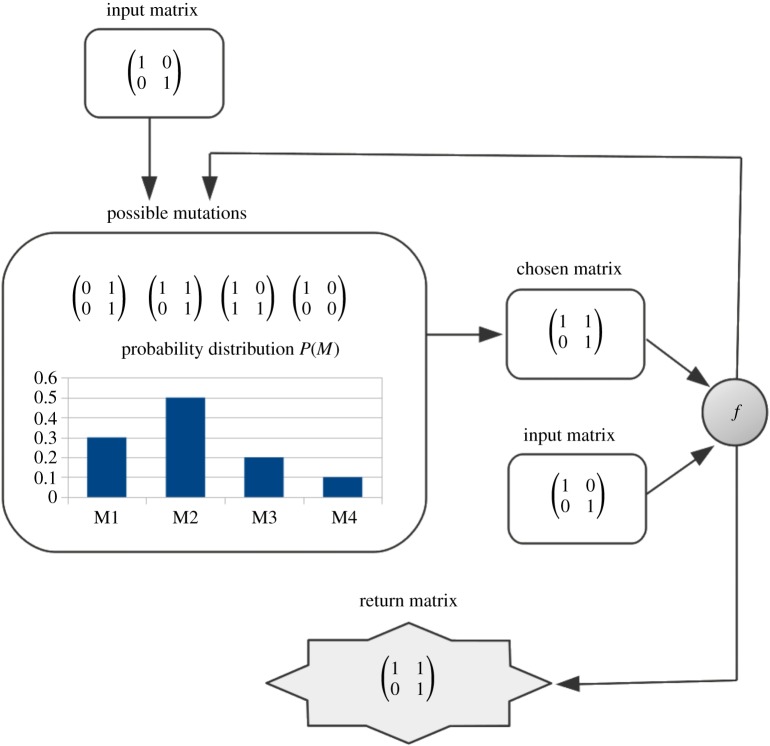
An evolution instance. The instances are repeated by updating the input matrix until convergence or extinction is reached.